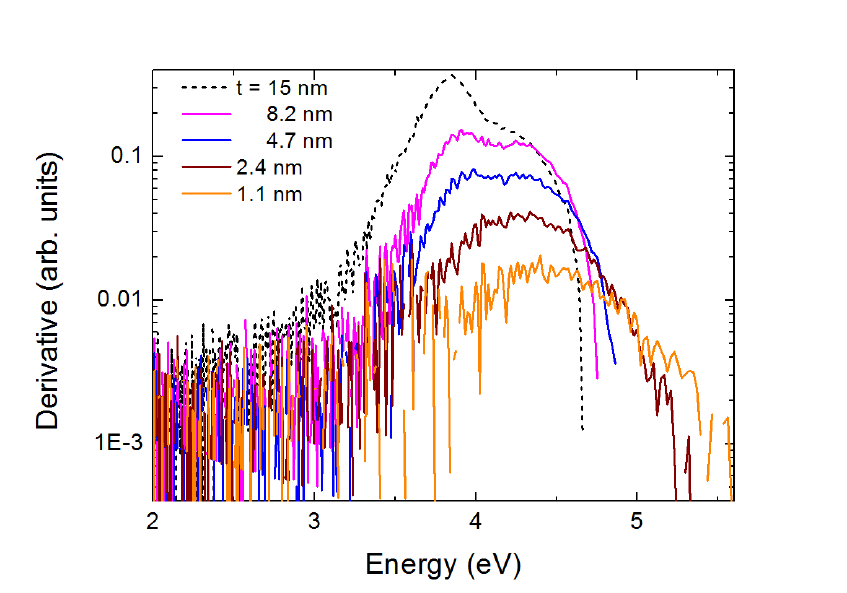
Figure 4. First derivative of the absorbance of the five films of Figure 3; their thickness t is indicated. A logarithmic scale is selected for the Y-axis for better presentation. The maximum of the derivative shows a “blue shift” with decreasing film thickness.